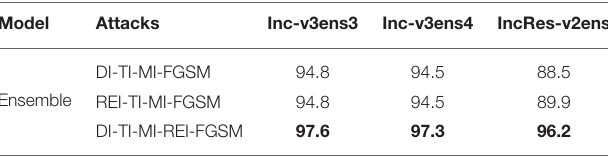
TABLE 4 | The success rate(%) of non-targeted attacks of three ensemble adversarial training